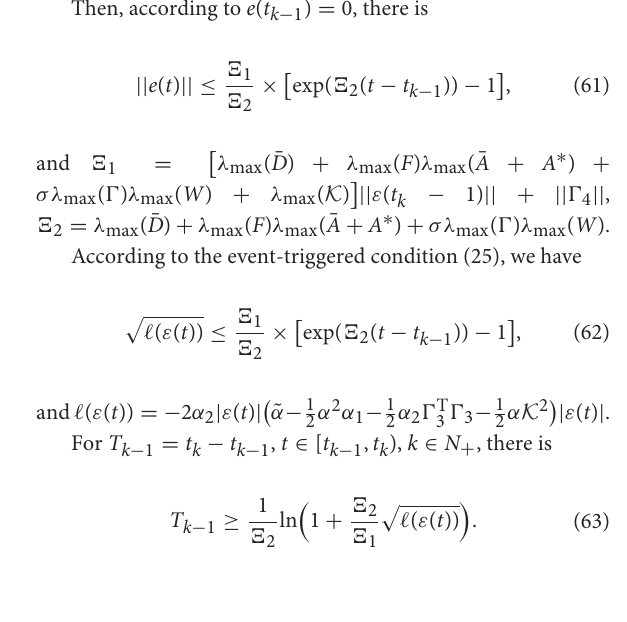
y ( t ) x ( t ) under the = −